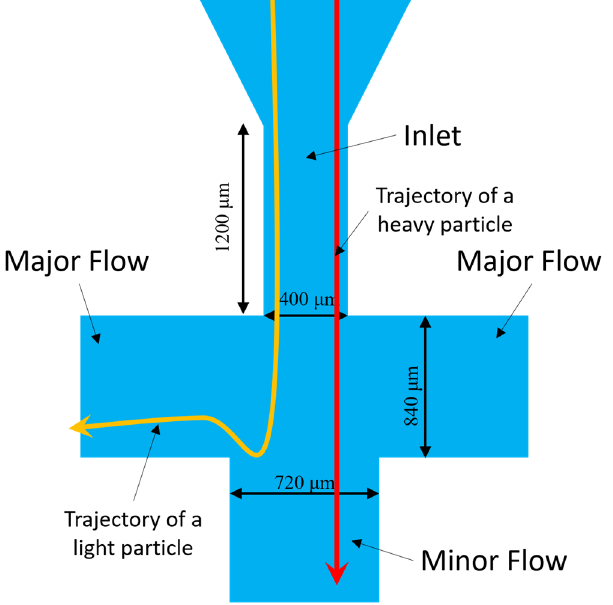
Figure 3. Virtual impactor with dimensions, showing the major and minor flow channels. The red line depicts the trajectory of a heavier particle, and the yellow line depicts the trajectory of a lighter particle.